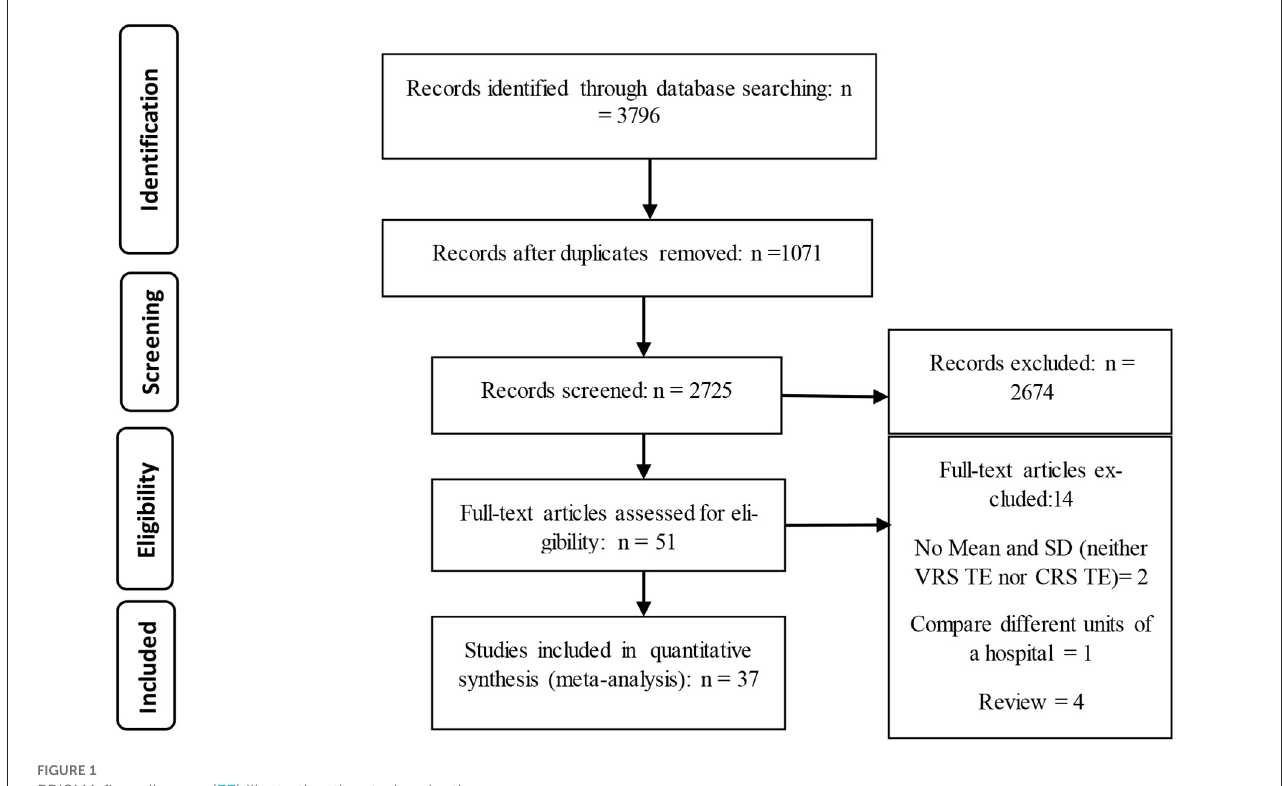
FIGURE1 PRISMA flow diagram (33) illustrating the study selection process.